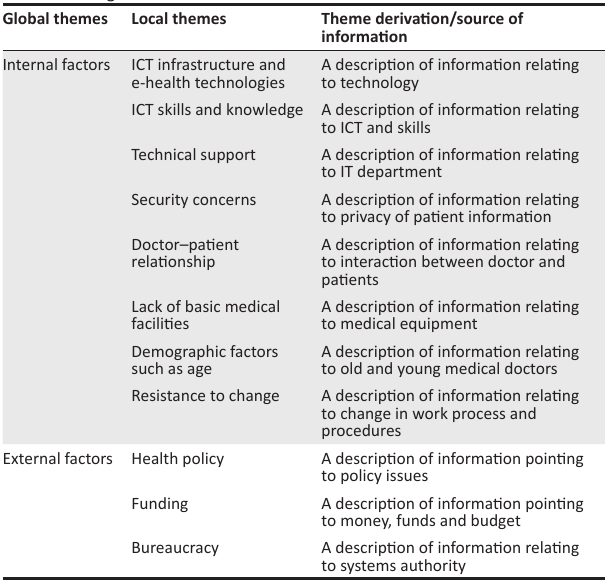
TABLE 1: Categorisation of